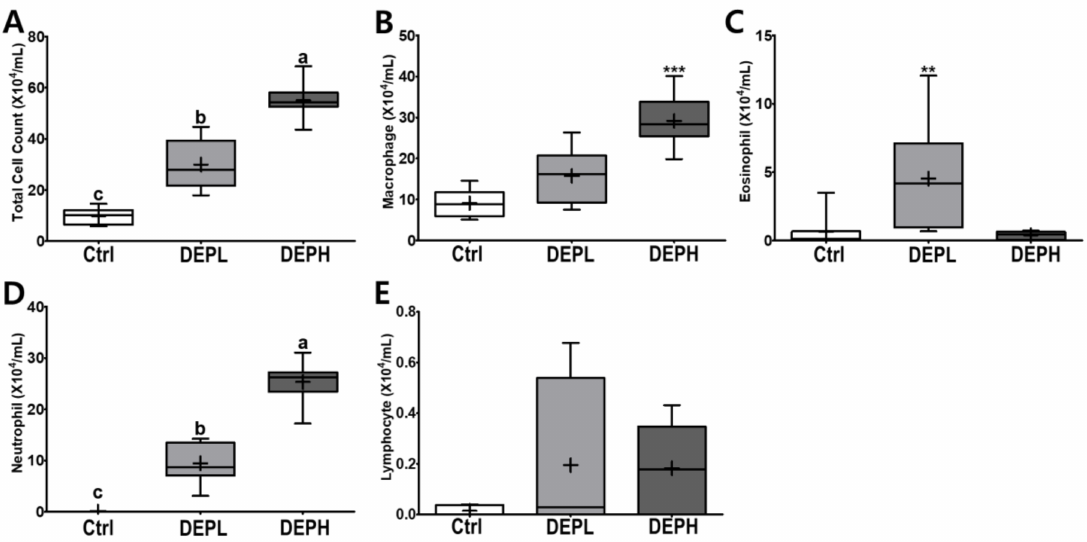
Figure 3. Box-and-whisker plots representing the absolute number of inflammatory cell profiles in the broncho-alveolar lavage fluid (BALF) after repeated exposures to diesel exhaust particles (DEP) for 7 consecutive days. All the cells within the BALF were counted and differentiated: ( A ) the total number of cells, ( B ) macrophages, ( C ) eosinophils, ( D ) neutrophils, and ( E ) lymphocytes; n = 8 for each group. One-way ANOVA was performed, followed by Tukey’s post-hoc test; labeled means without a common letter differ ( p < 0.05); ** p < 0.01; *** p < 0.001.